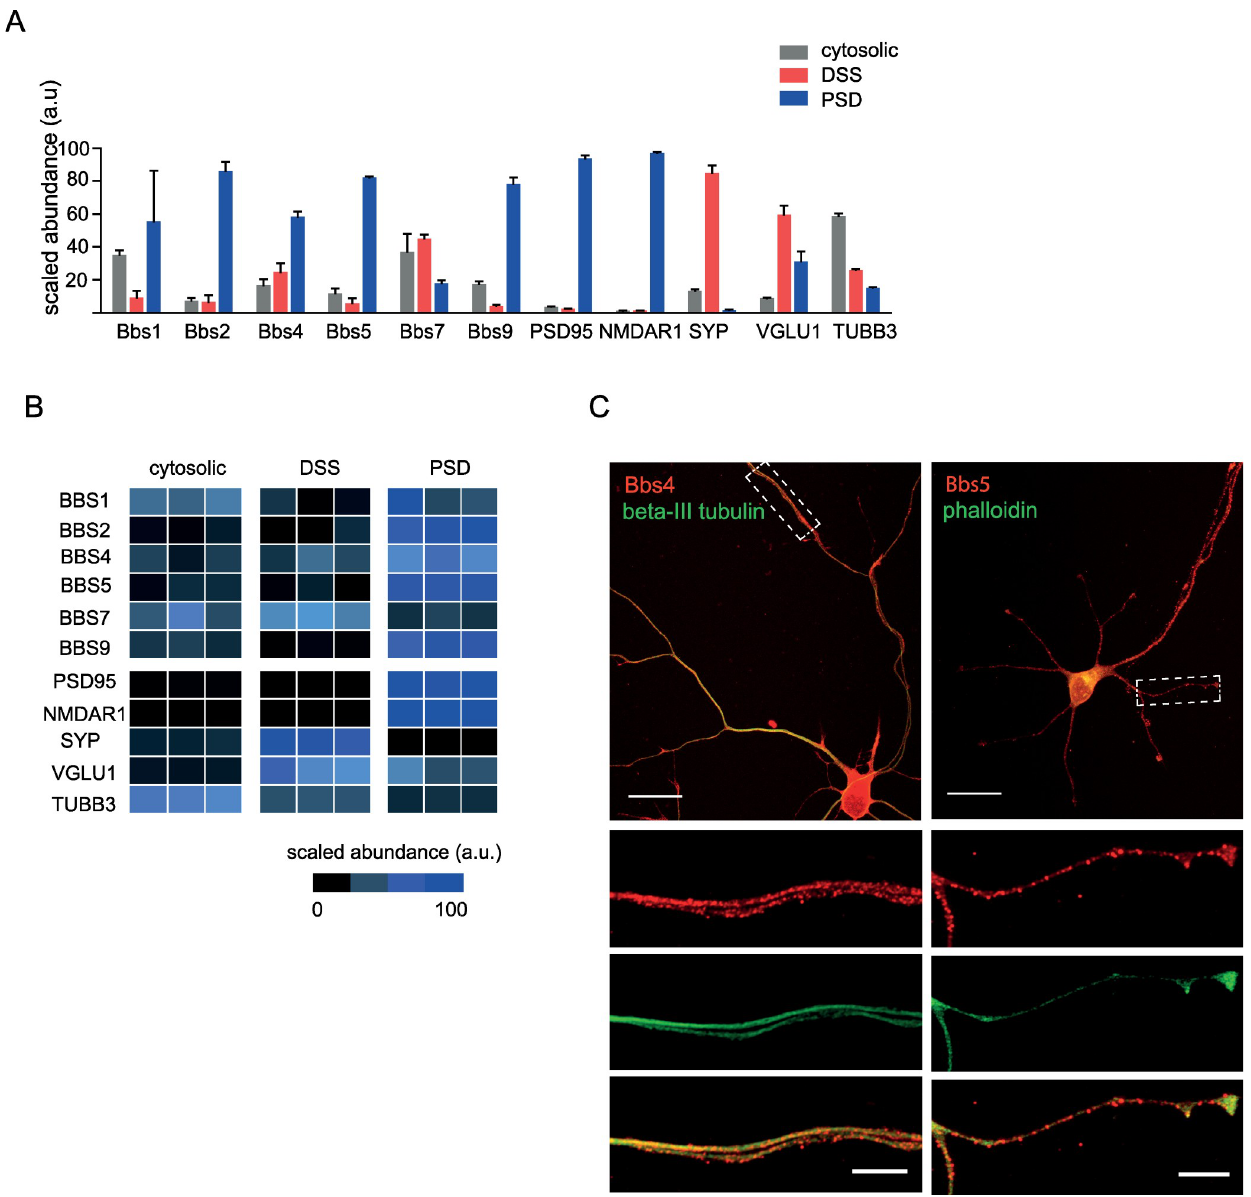
Fig 5. Biochemical and immunocytochemical profiling of BBS proteins. (A) Proteomic profile of the BBS proteins in biochemical fractions using nano- LC-MS/MS analysis. Protein levels of Bbs proteins and synaptic markers were estimated by label-free LC-MS analyses from following biochemical fractions of the rat hippocampi: cytosolic, detergent-soluble synaptosomal preparation (DSS, pre-synapse enriched), and postsynaptic density preparation (PSD). Protein levels of the presynaptic (VGLU1, SYP) and postsynaptic (NMDAR1, PSD95) protein markers are enriched in DSS and PSD preparations, respectively. (B) The protein abundances illustrated in the heat map are obtained from the total MS1 peptide intensities scaled to the mean of all the samples. Protein levels of the presynaptic (VGLU1, SYP) and postsynaptic (NMDAR1, PSD95) protein markers are enriched in DSS and PSD preparations, respectively. (C) Representative image of immunolabelling of Bbs proteins. Cultured mouse hippocampal neurons at low density were immunolabelled with Bbs4 and Bbs5 antibodies (red), phalloidin (green), and beta-III tubulin (green) after 6 days in vitro (DIV6). Scale bar, 20 μ m (top panel) and 5 μ m (bottom panels). Underlying data are available in S4 Data. BBS, Bardet-Biedl syndrome; DIV6, six days in vitro hippocampal culture; DSS, detergent-soluble synaptosomal; LC-MS/MS, liquid chromatography- tandem mass spectrometry; MS, mass spectrometry; NMDAR1, N-methyl-D-aspartate receptor 1; PSD, postsynaptic density; SYP, synaptophysin; TUBB3, β -tubulin III encoded by TIBB3 gene; VGLU1, vesicular glutamate transporter 1. reduced phosphorylation of IRS p58, and aberrant activity of the small GTPases Rac1 and RhoA in Bbs4 − / − synaptosomal fractions. All these events are known to have a diminishing